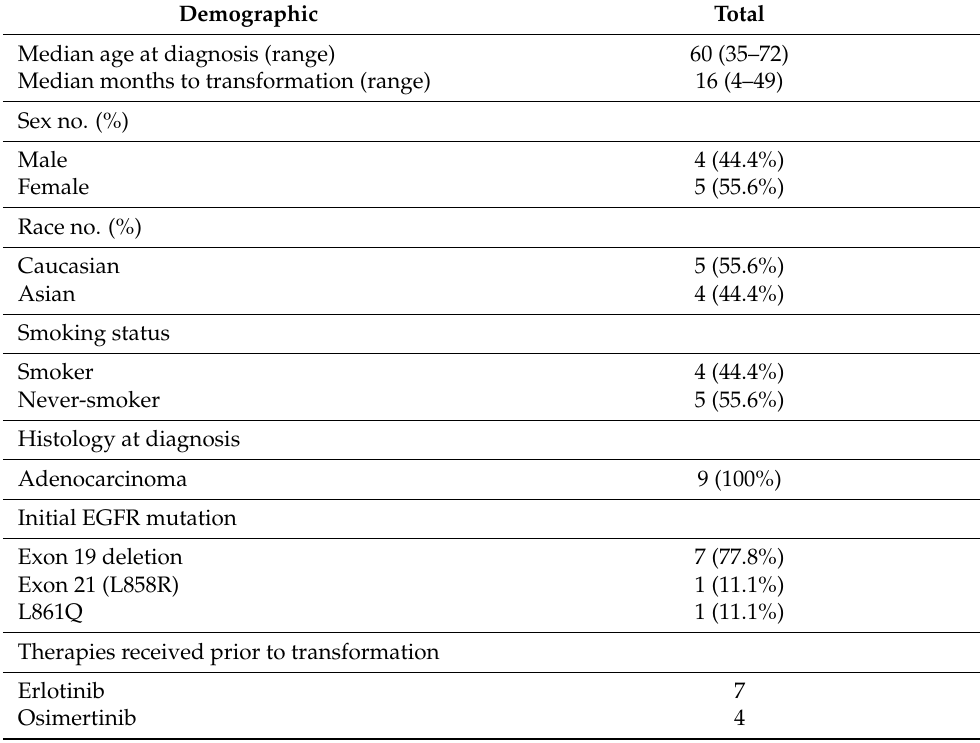
Table 2. Patient demographics and